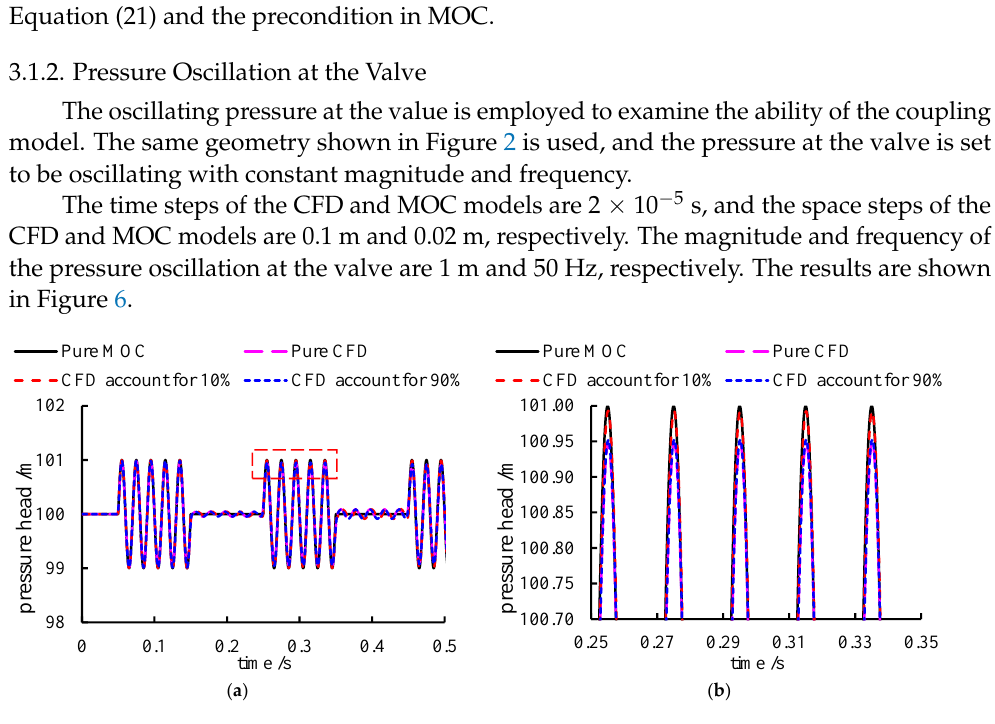
Figure 6. Pressure head variation at the center of the entire system. ( a ) Overview ( b ) zoom-up view.